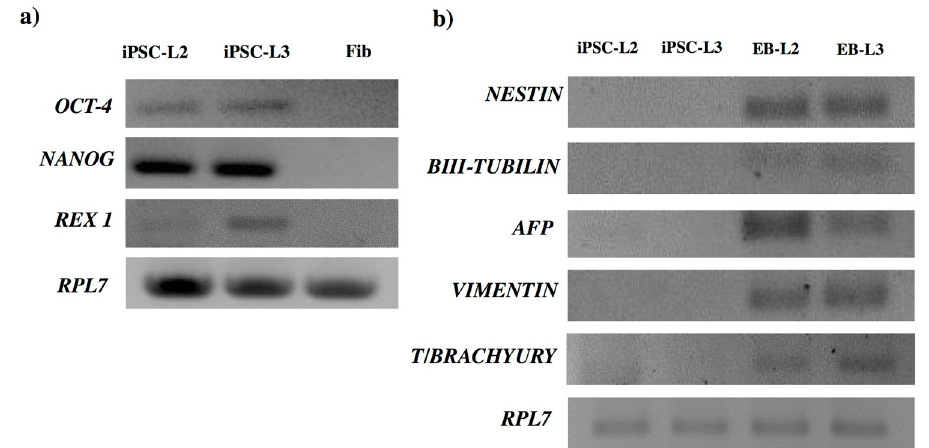
Fig 2. End point PCR analysis of iPSCs. a) the pluripotent genes OCT-4 , NANOG and REX1 in fibroblasts (Fib) and both iPSCs lines L2 and L3; and b) representative genes from the three germ layers in L2 and L3 iPSCs, and embryo bodies (EB), derived from these both iPSCs lines (EB-L2 and EB-L3, respectively). RPL7 was used as the housekeeping